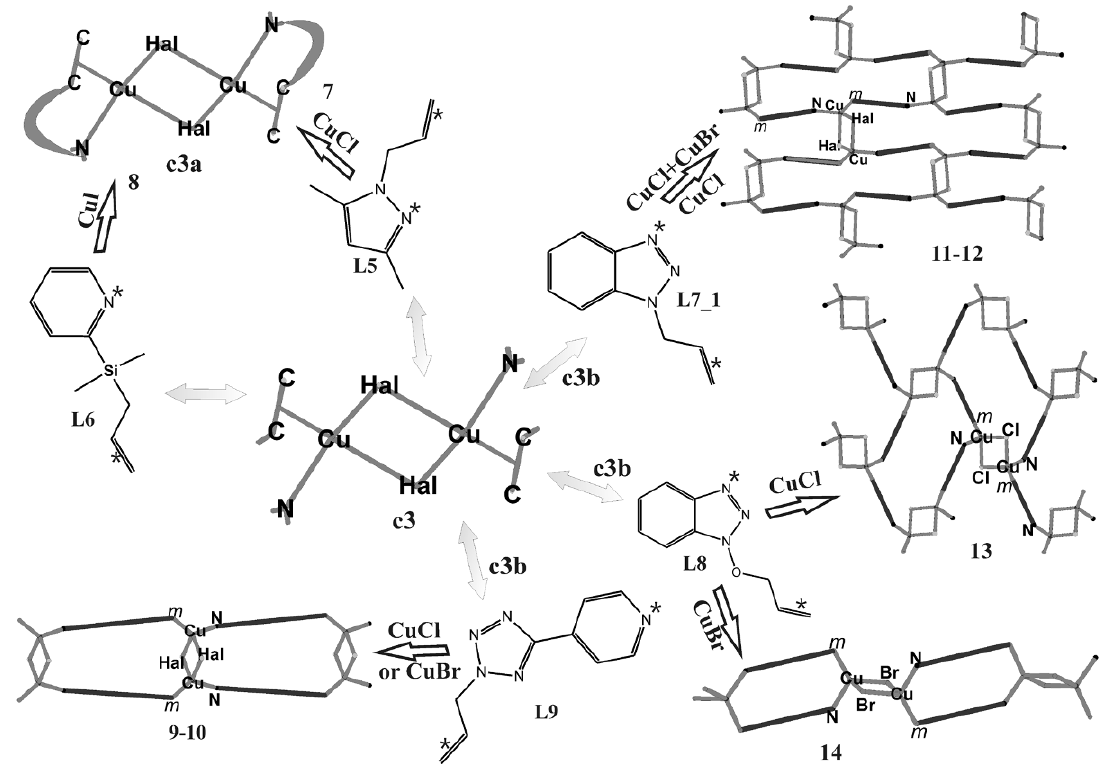
Figure 3. Structural genesis of C3 fragment in 7-14